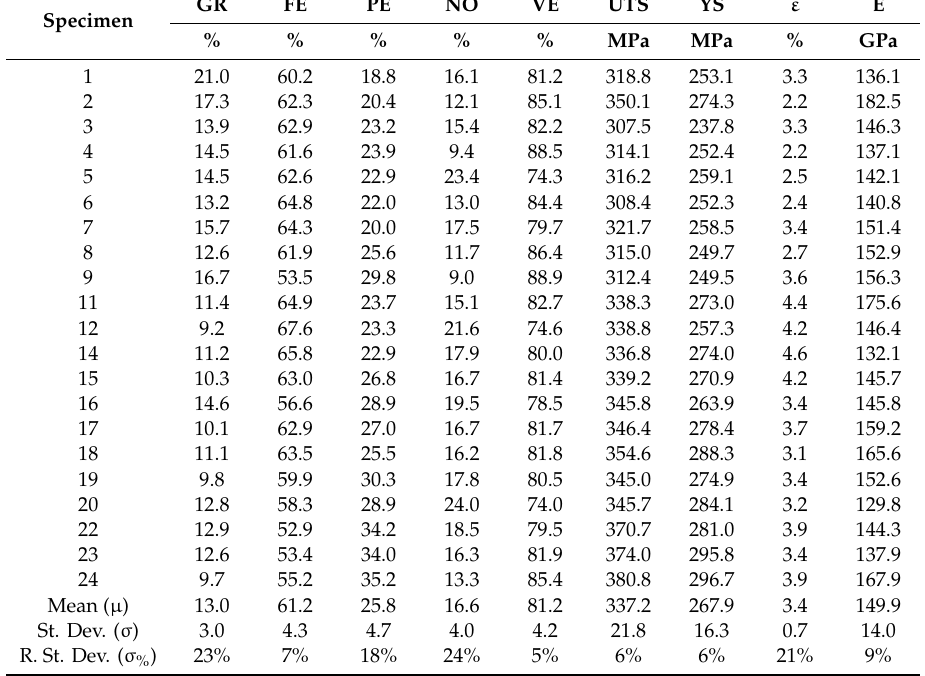
Table A2. Metallographic and mechanical properties of specimens in Compacted Graphite Iron (CGI). Data from [21–23].